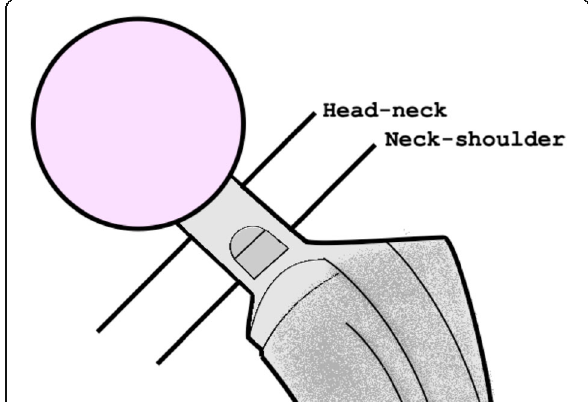
Fig. 1 Two types of hip neck fractures: head-neck fractures are located at the proximal part of the neck and neck-shoulder fractures at the distal part of the